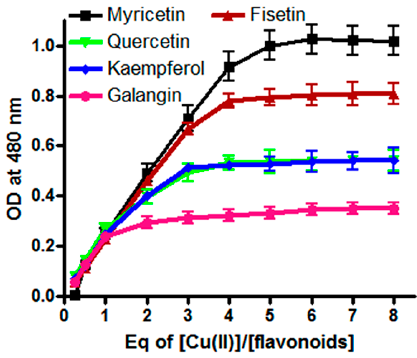
Figure 3. Stoichiometry of Flavonoid–Cu(II) interactions. The concentration of myricetin, fisetin, quercetin, kaempferol and galangin was 10 µM in the presence of 0.3 mM bathocuproine (10 mM Tris–HCl). All the points are representative of triplicate samples and mean values are plotted.